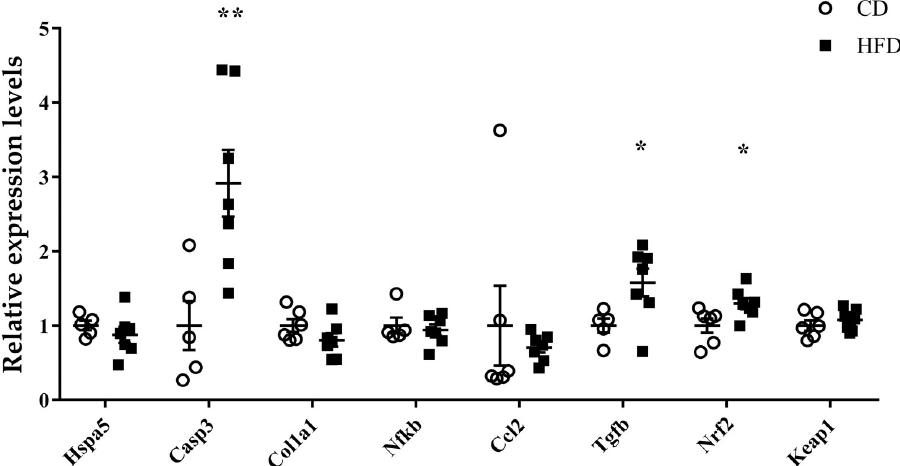
Fig 5. Gene expression analyses. Relative gene expression levels of Hspa5 , Casp3 , Col1a1 , Nfkb1 , Ccl2 , Tgfb1 , Nfe2l2 , and Keap1 analyzed by quantitative reverse transcription-polymerase chain reaction (qRT-PCR) in C57BL6/J mouse renal tissue homogenates. ACTB is the internal control. The expression levels are presented relative to the control group. Bars indicate mean ± SEM. � p < 0.05; �� p < 0.01 (unpaired t-test). n = 5 or 6 in CD and 7 in HFD, respectively. CD, control diet group; HFD, high-fat diet